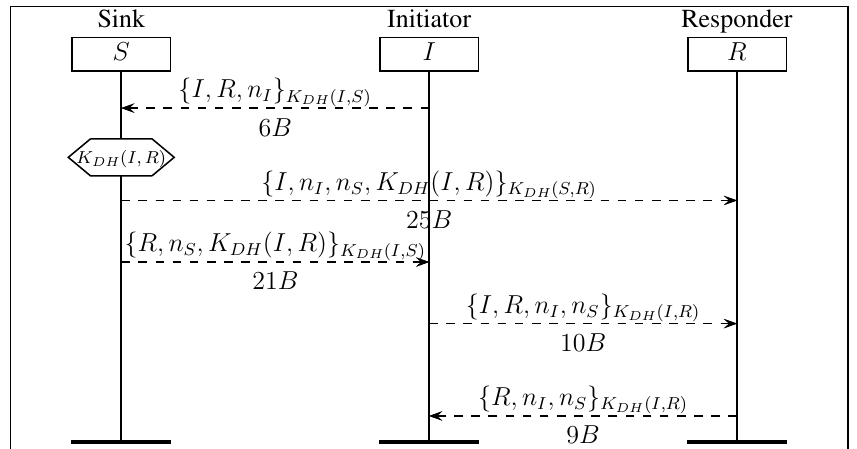
Figure 4. MKE − light : Multi-hop Key Establishment using the sink S to compute and S deliver K ( I, R ) to the initiator and the DH